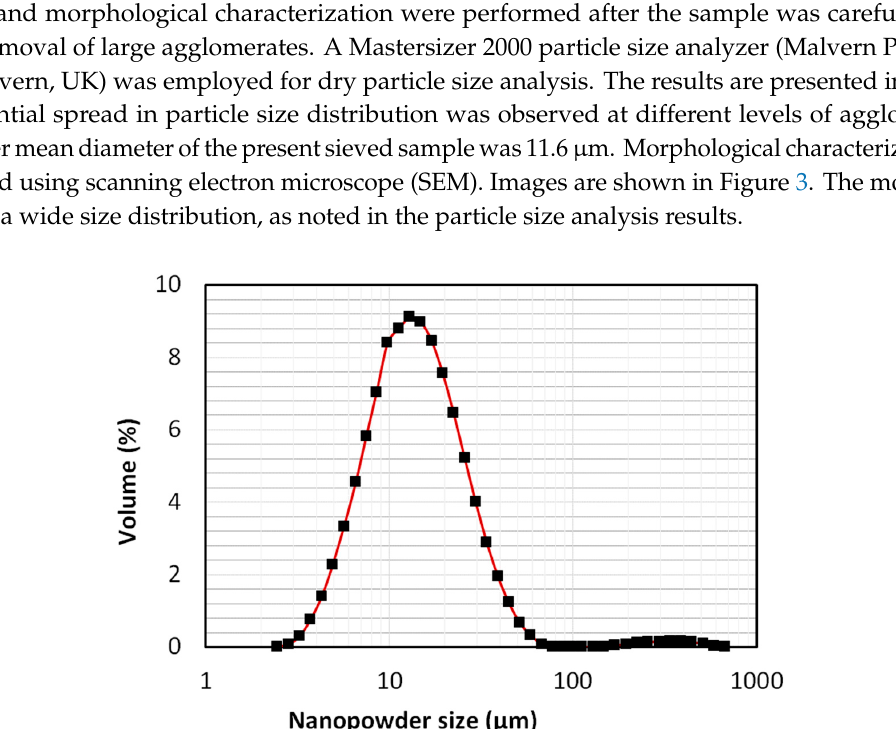
Figure 3. SEM image showing different levels of agglomeration of the nanopowder. The flow controllers and pressure transducers were carefully calibrated before the experiments. The column was thoroughly rinsed with an antistatic fluid to minimize the effect of electrostatic on the column walls. The vertical alignment of the column was ensured using a level meter. The samples were sieved to eliminate large agglomerates, which often form during their storage over time. Then, 62 g of the nanopowder (hydrophilic fumed silica) was loaded, and the column wall was frequently tapped. The mixture was left overnight to settle. The static bed height was 370 mm